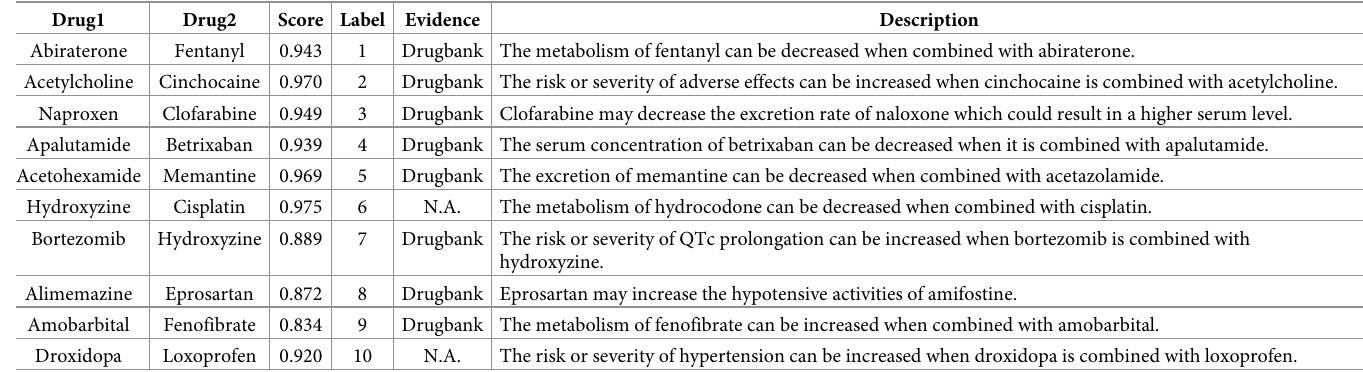
Table 6. Case study prediction